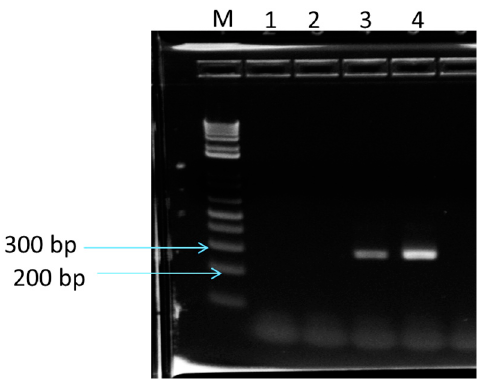
Figure 3. E-Gel (2% Agarose gel) electrophoresis of PCR products for cry 1 genes. Lane M: E-Gel 1 Kb Plus DNA Ladder; Lane 1: sterile water, Lane 2: B. megaterium ATCC 6458; Lane 3: B. thuringiensis subs. kurstaki ATCC 35866 as cry 1 positive control; Lane 4: strain mislabeled B. megaterium.